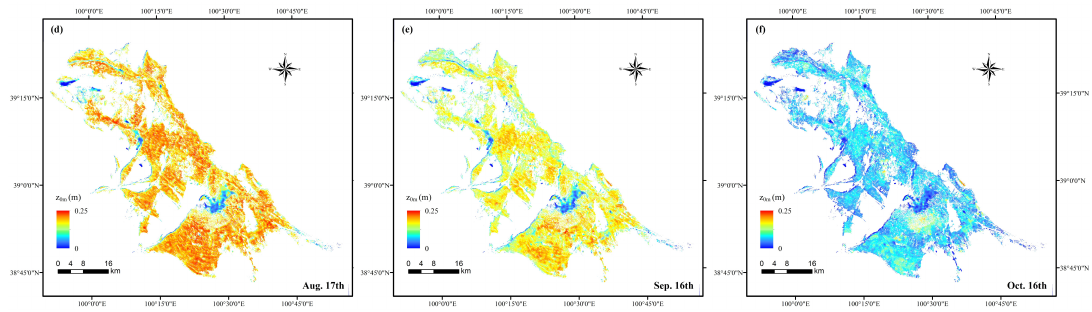
Figure 8. Estimated aerodynamic roughness lengths of spring maize in the middle reach of the Heihe River Basin on: ( a ) 19 May; ( b ) 18 June; ( c ) 18 July; ( d ) 17 August; ( e ) 16 September; and ( f ) 16